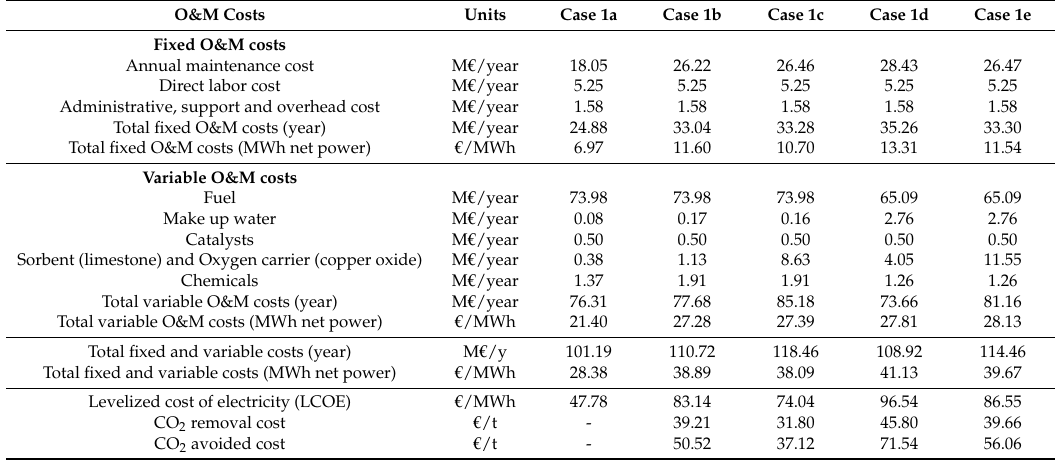
Table 5. Operation and maintenance (O&M) costs, CO 2 capture costs and levelized cost of electricity for oxy-combustion power plants.